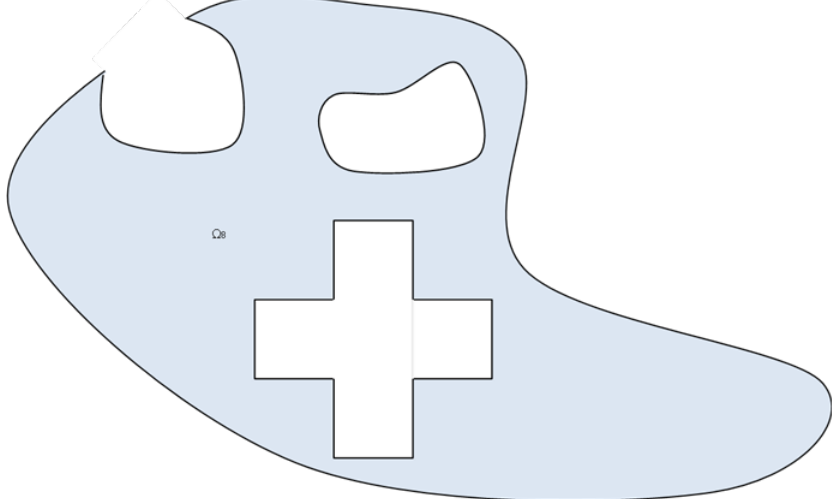
Figure A1. The reservoir from the perspective of Region 8.